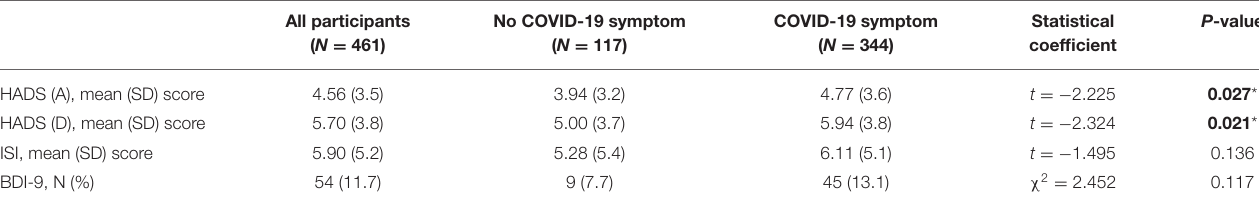
All participants No COVID-19 symptom COVID-19 symptom ( N = 461) ( N = 117) ( N = 344)